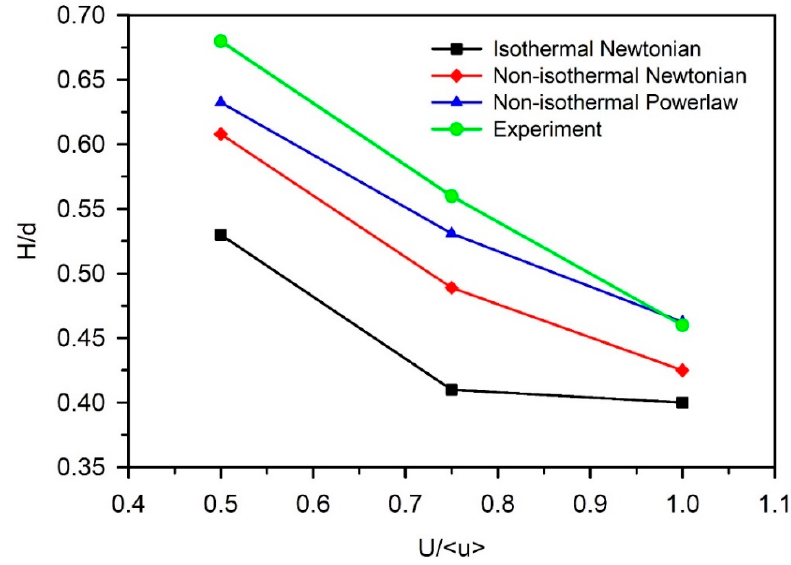
Figure 9. Comparison of H / d vs. U /< u > for g / d = 0.4 obtained from simulations and the experiment. Isothermal Newtonian simulation results are from Serdeczny et al. [15] which we were able to reproduce using our model. (Lines connecting symbols are for visual guidance).